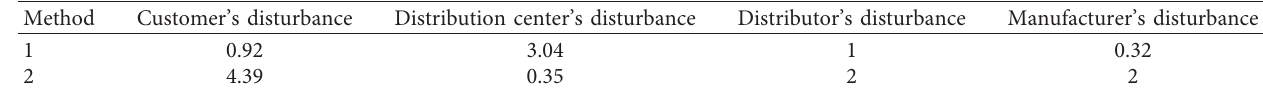
Table 4: Solution results of different methods.